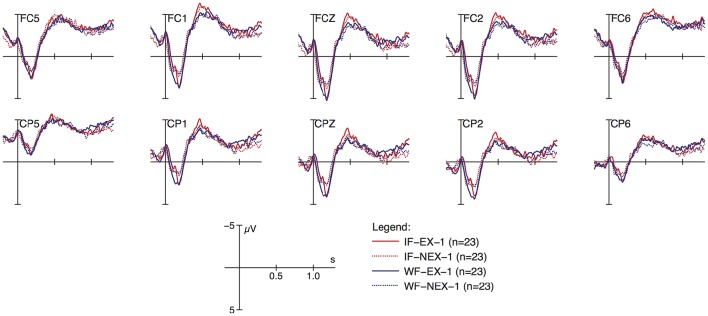
ERP responses to stimuli at anterior (top) and posterior (bottom) electrodes; data from response-elicitation phase, session 1.